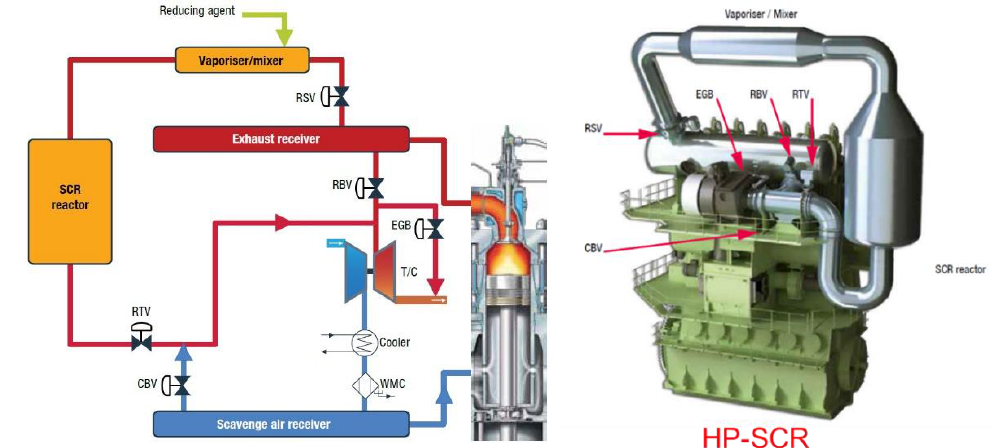
Figure 2. HP-SCR system developed by MAN [18].